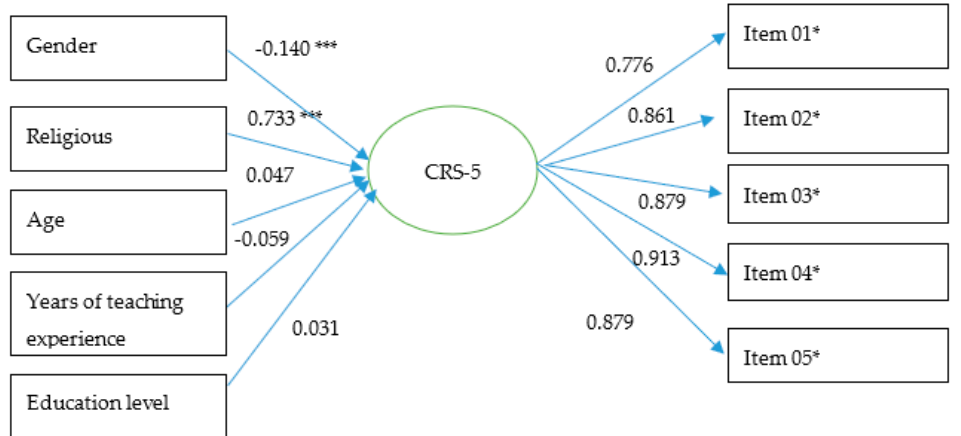
Figure A1. MIMIC model for CRS-5; * Item 01 to Item 05 refer to Item 01–05 in Appendix D; *** p < 0.001.